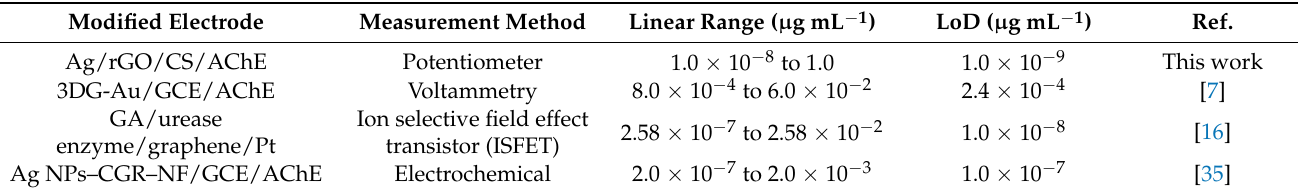
Table 1. Comparison of the linear range and LOD of modified membranes for carbaryl detection with current